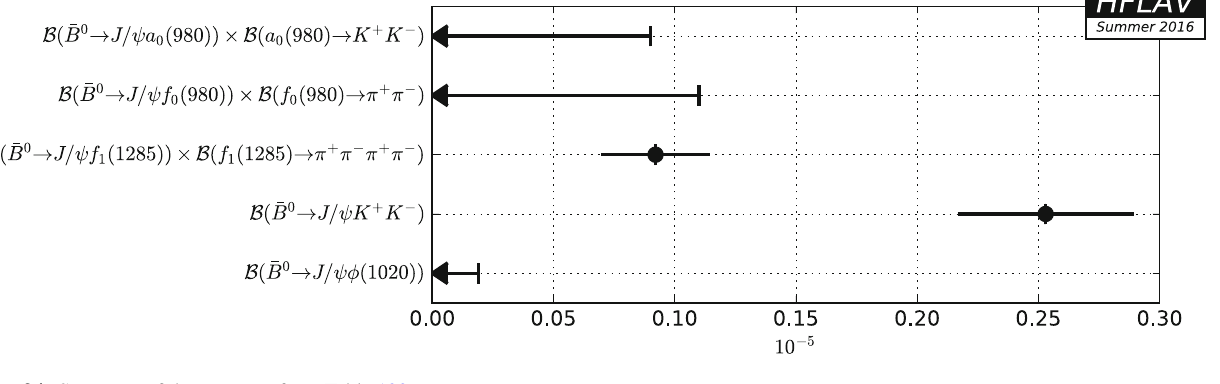
Fig. 94 Summary of the averages from Table